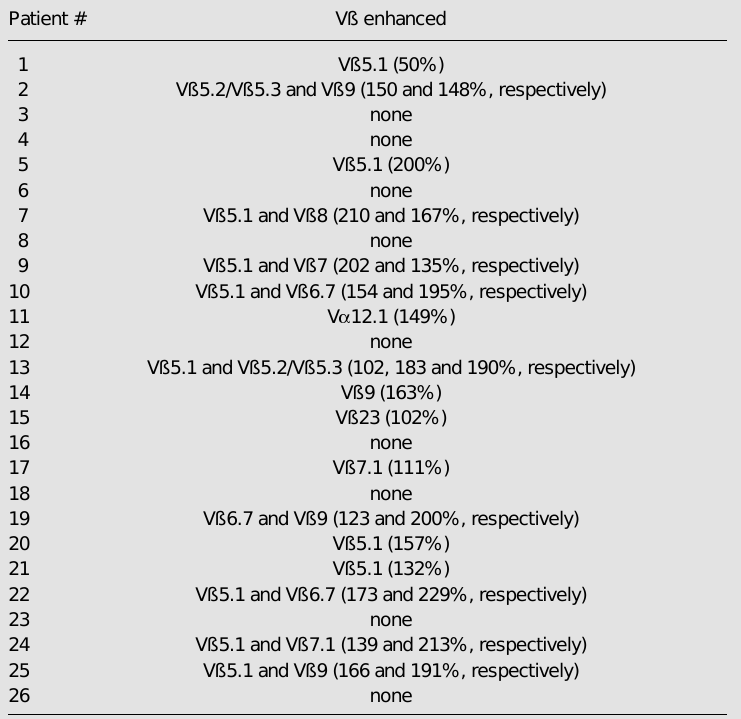
Table 1. Vß expression in peripheral blood mononuclear cells from seronegative individuals after stimulation with soluble toxoplasma tachyzoite antigen (STAg). Patient #